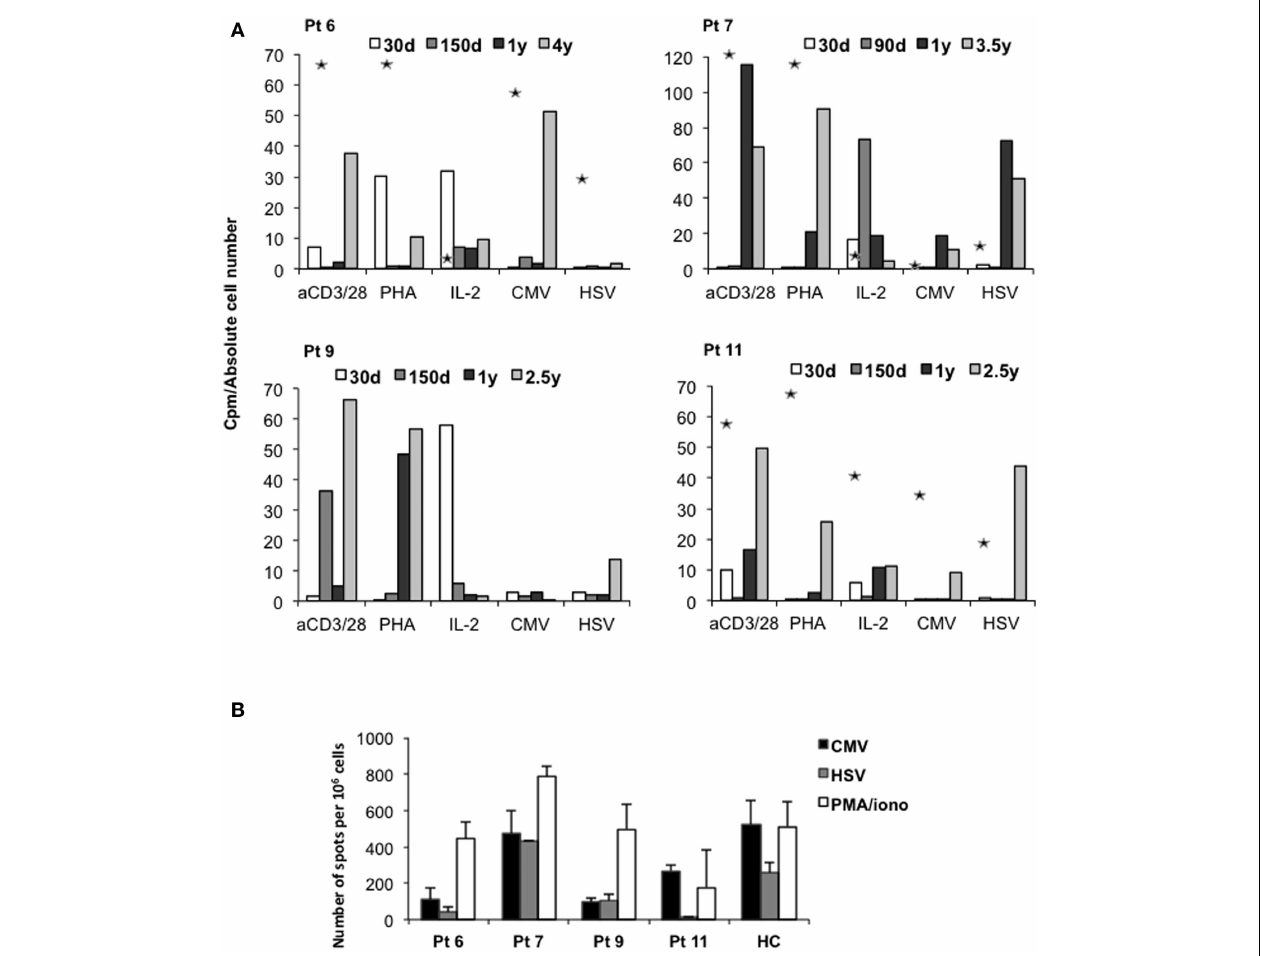
normalized to the number of CD3 + T cells. Asterisks indicate proliferative responses of haploidentical donor PBMC before transplant. Pt: patient; d: days; y: years. (B) Frequency of CMV- and HSV-specificT cells producing interferon (IFN)- γ in patients’ PBMC. Bars represent the number of IFN- γ producingT cells specific for CMV, HSV and PMA + ionomycin (PMA/iono) in peripheral blood of patients (patients 6, 7, 9, and 11) tested 4, 3.5, 2.7, and 2.5years after IL-10-DLI, respectively. Healthy controls (HC) were tested in parallel. Pt: